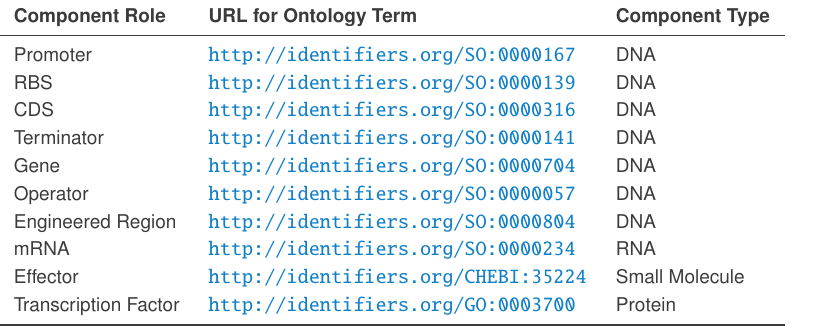
Table 4: Partial list of ontology terms to specify the role property of a Component , organized by the type of Component to which they are intended to apply (see Table